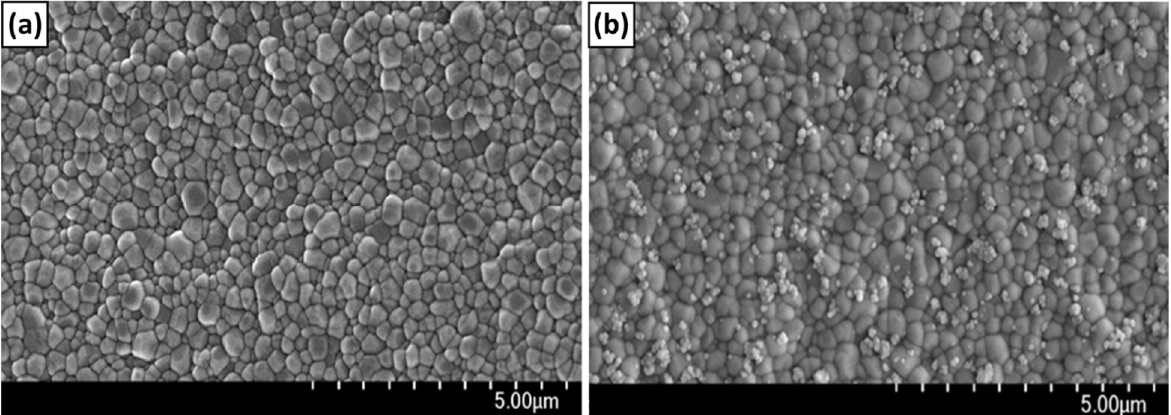
Figure 5. Scanning electron microscopy images of ZrO 2 disk ( a ) and ZrO 2 –HA disk ( b ). It can be seen that the zirconia disk ( a ) obtained by injection molding is composed of granules with a diameter of 200 to 500 nm. On the other hand, after the nHA reaction, single nHA and nHA clusters were bound to the zirconia surface in a dispersed state.